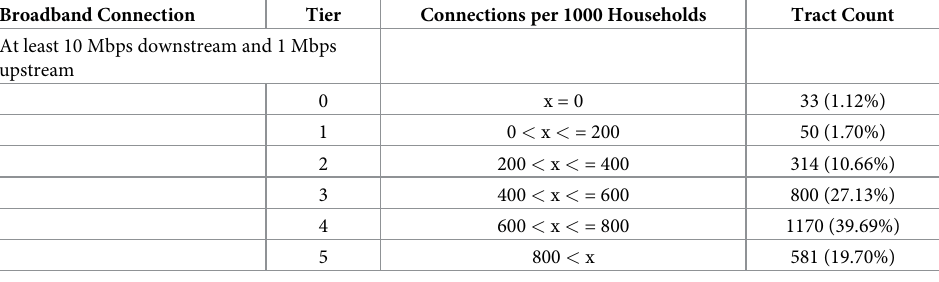
Table 4. Fixed residential broadband connections per 1,000 households by census tract: Ohio